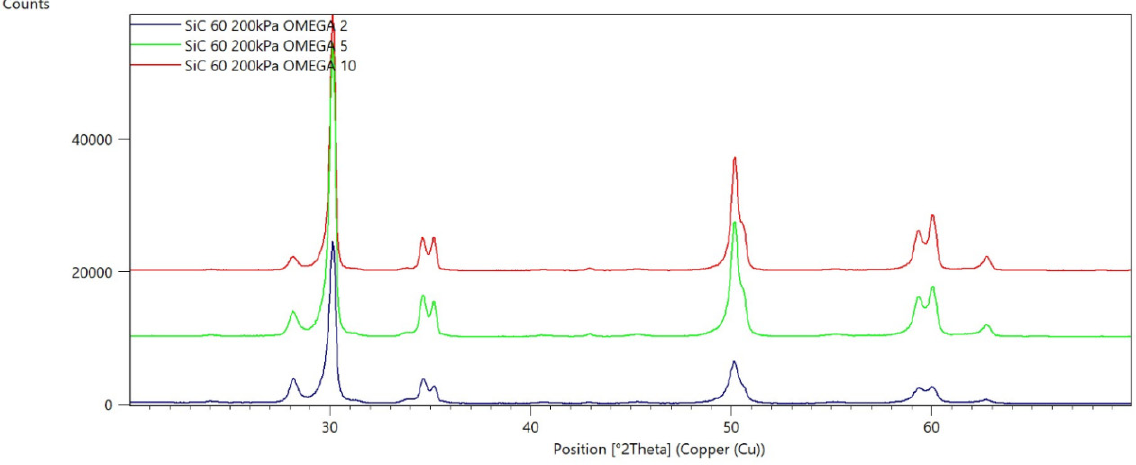
Figure 8. Diffraction patterns of the G sample (abrasive—SiC 60 µ m, pressure 200 kPa).